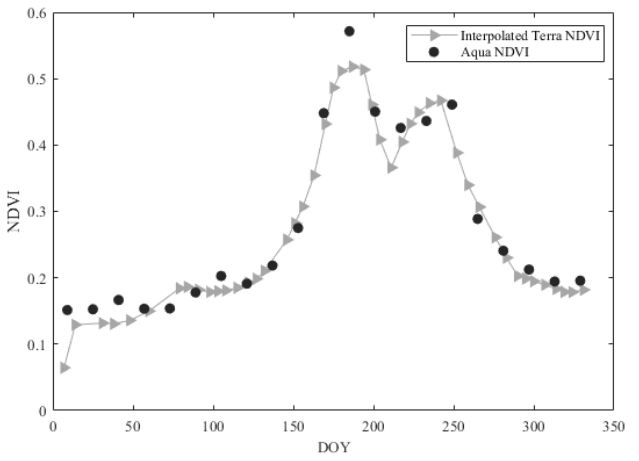
Figure 3. Comparison of interpolated Terra NDVI with Aqua NDVI products over a representative station (L02) in 2015.